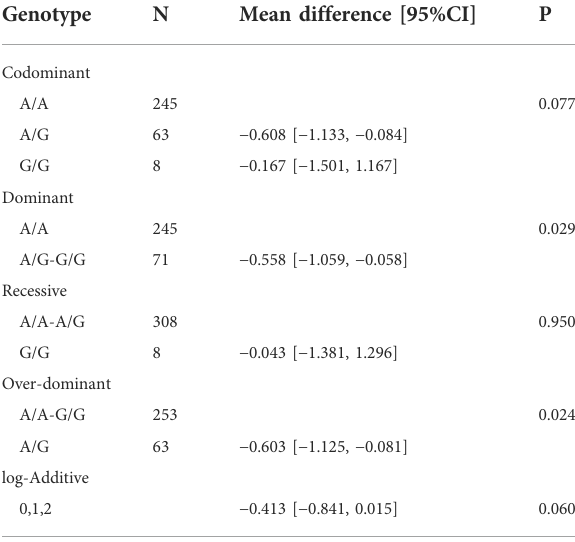
TABLE 4 Association between rs4880 in SOD2 and fasting glucose.